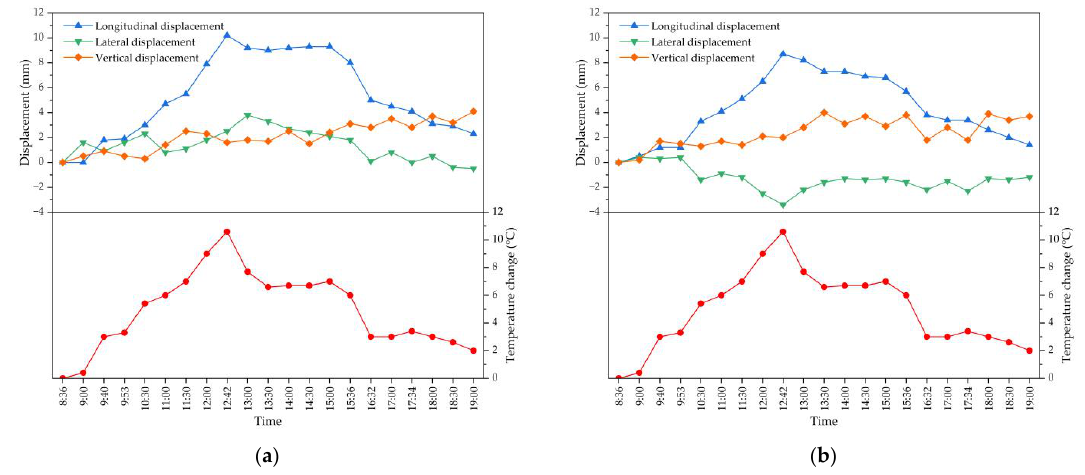
Figure 13. The continuous temperature and deformation monitoring of suspender N14 for the lattice beam: ( a ) on the left; ( b ) on the right.